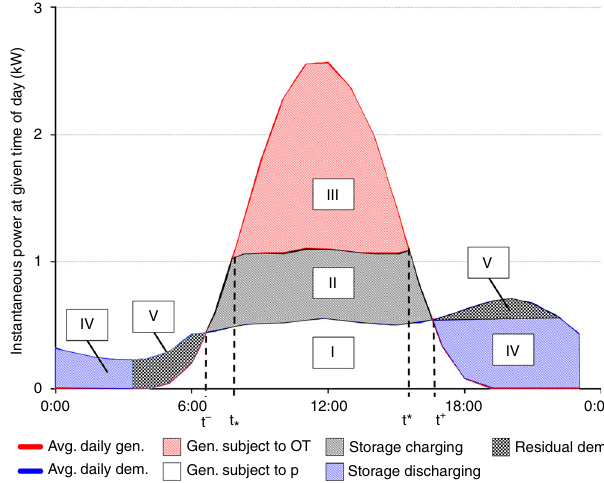
Fig. 2 Pattern of daily charging and discharging of a battery supplementing a PV system. Region I represents self consumption from solar generation; region II is surplus energy that can be stored and subsequently discharged as region IV (minus ef fi ciency losses); and region III is surplus energy sold to the grid. Region V is residual demand that would not be met by the battery and must be met through purchases from the grid at the going retail rate